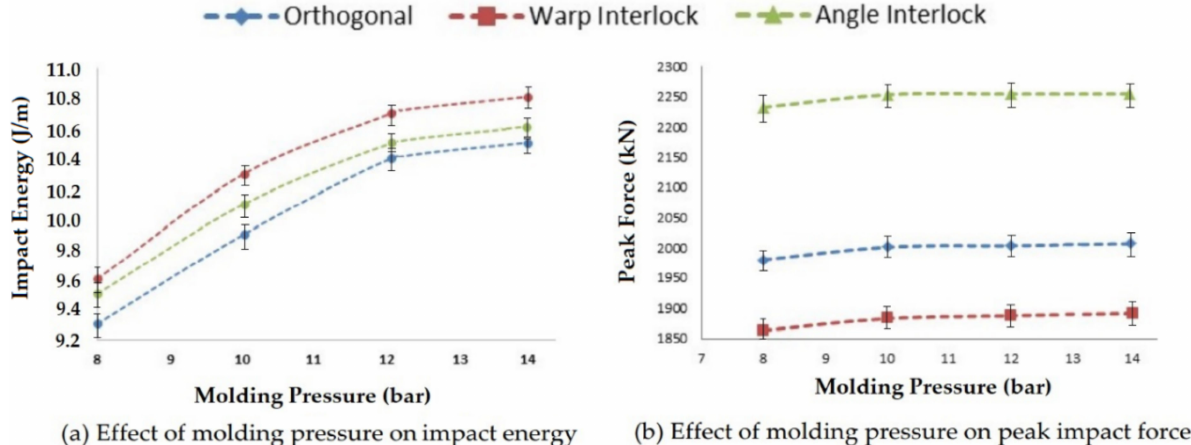
Figure 16. Effect of molding pressure on the impact properties of 3D woven